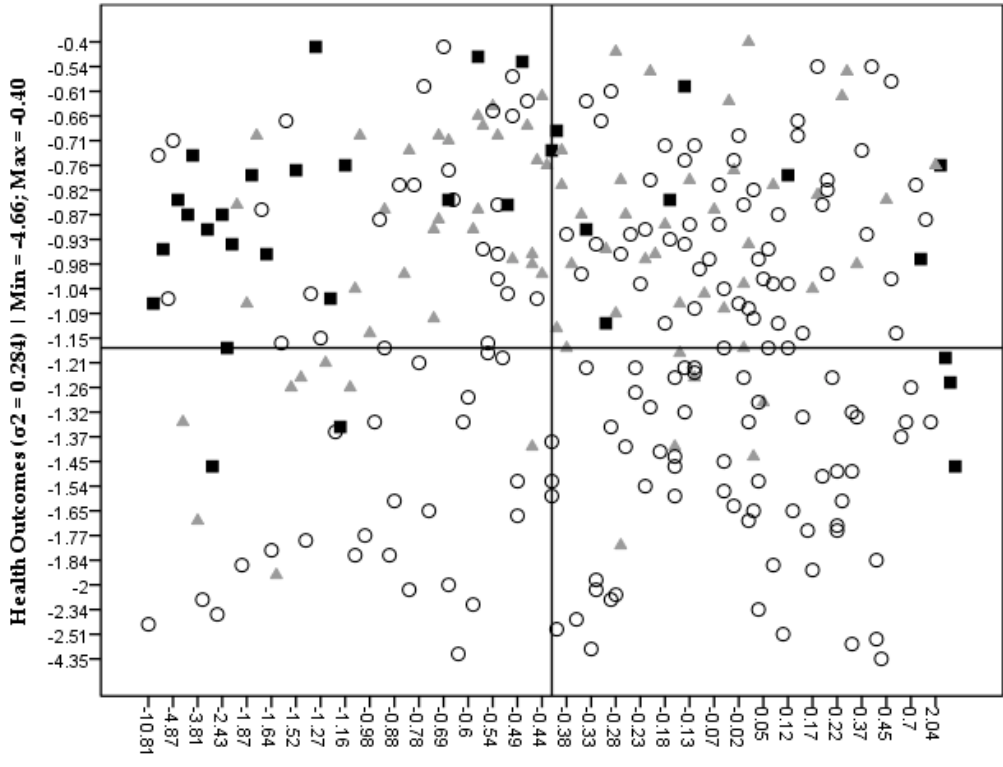
Figure 2. Scatter plot of health determinants (x-axis) and health outcomes (y-axis) value-scores by territory typology and corresponding variance ( σ 2 ) and minimum/maximum scores: (a) 2009; (b) 2015; (c) 2017/2018. Each symbol represents one municipality. ■ Predominantly urban; ▲ semi-urban; ○ predominantly rural. Table 4. Descriptive statistics by territory